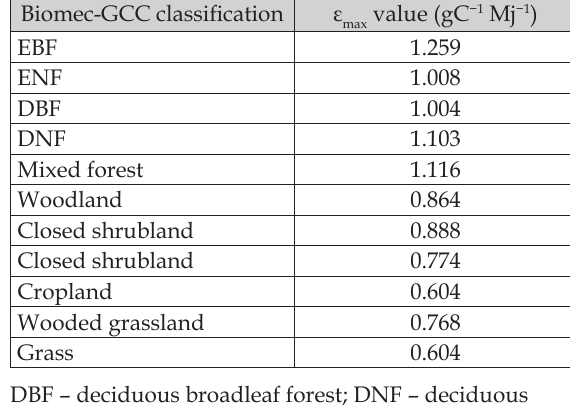
Table 3. Value of ε based on Biomec-GCC classifi - max cation (acc. to Running et al.